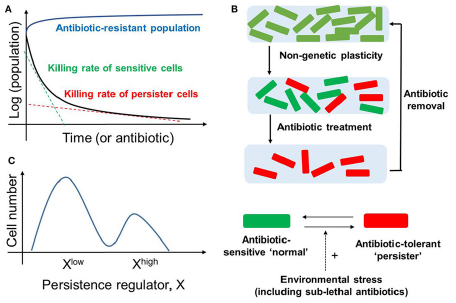
Figure 1. Bacterial Persistence. ( A ) Biphasic time-kill curve in bacterial populations exposed to antibiotics: faster killing rate of sensitive cell (green dotted line) followed by a slower killing rate (red dotted line) of the persisters. In contrast, the antibiotic-resistant population continues to grow in the presence of antibiotic (blue curve). ( B ) (top) An isogenic population of antibiotic sensitive cells can give rise to persisters via non-genetic/phenotypic plasticity. These slow cycling persisters survive in the antibiotic treatment and tend to resume growth and generate a new population identical to the original population upon antibiotic removal (bottom). Persisters and non-persisters can switch among one another; the switching rate can be influenced by external stress factors. ( C ) Non-genetic heterogeneity of a key regulator of persistence (say X) in an isogenic population may give rise to two (or more) subpopulations that may continue switching stochastically among themselves to maintain persistence [25].